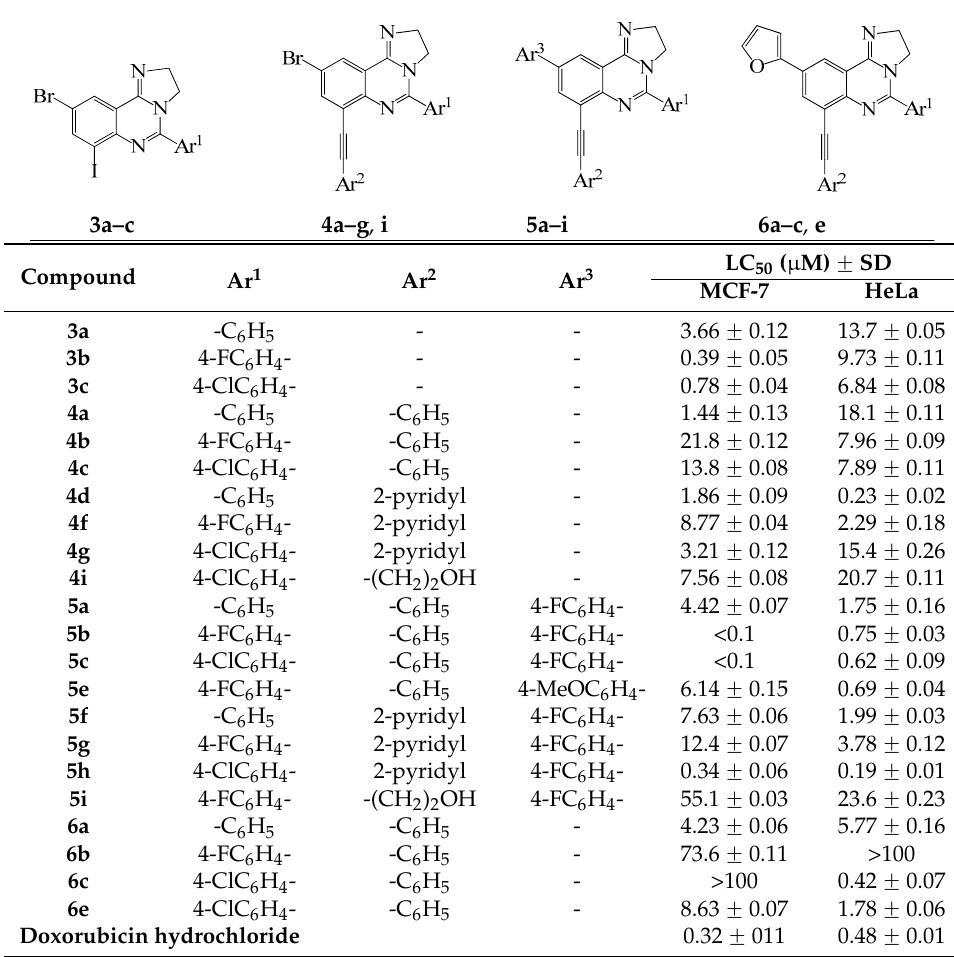
Table 1. Cytotoxic effects of imidazo[1,2- c ]quinazolines 3 – 6 against human breast adenocarcinoma (MCF-7) and human cervical cancer (HeLa) cell lines.